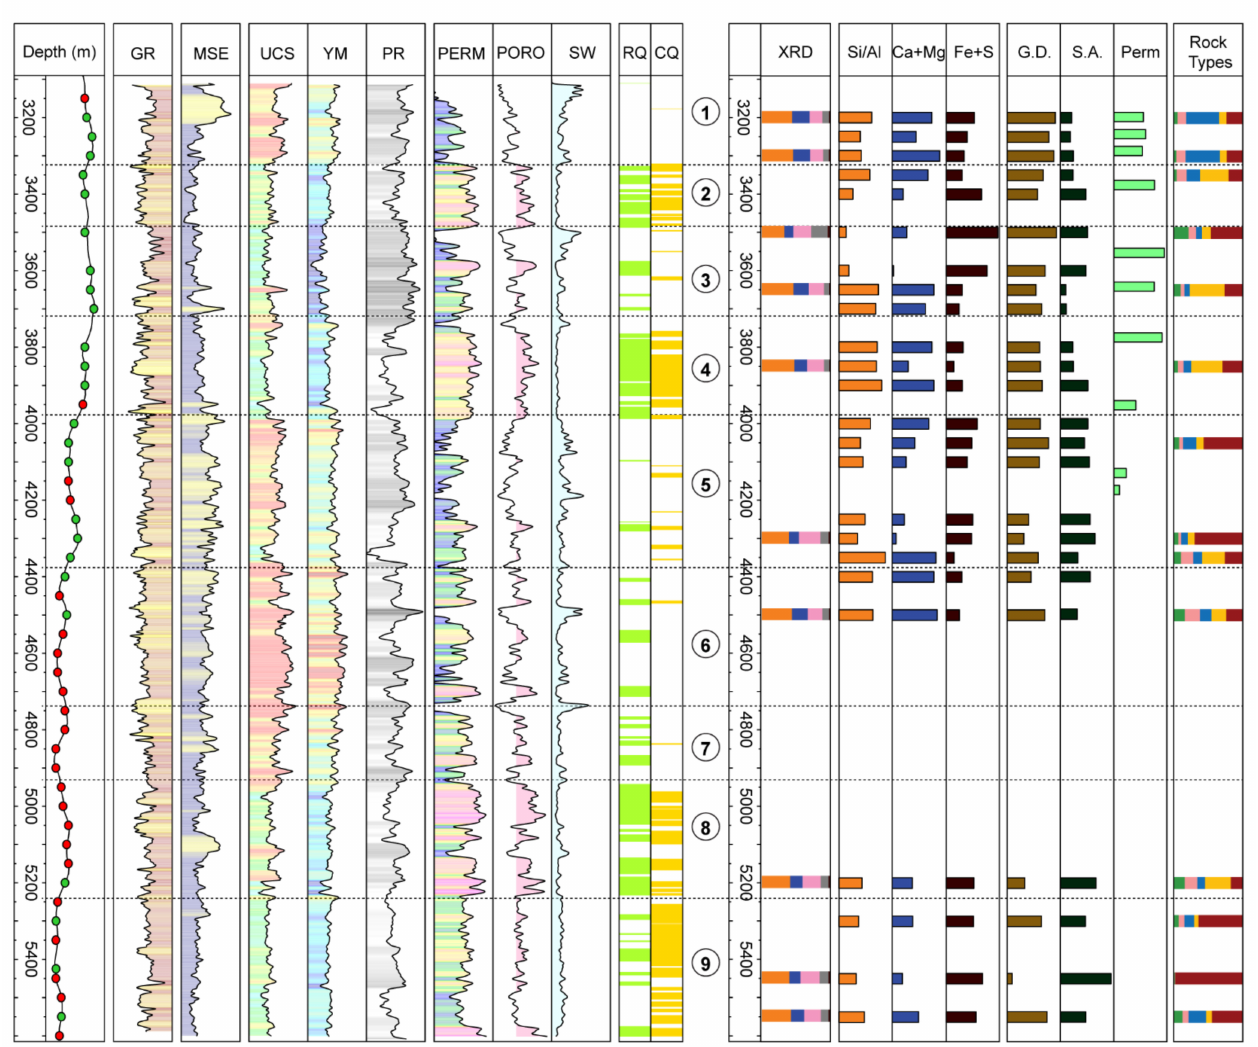
Figure 10. Summary plot showing the integration of log-derived reservoir properties, mechanical specific energy (MSE) log, and the laboratory analyses conducted on the drill cuttings. The nine segments were subdivided based on the lateral variations on the log-calculated petrophysical and geomechanical